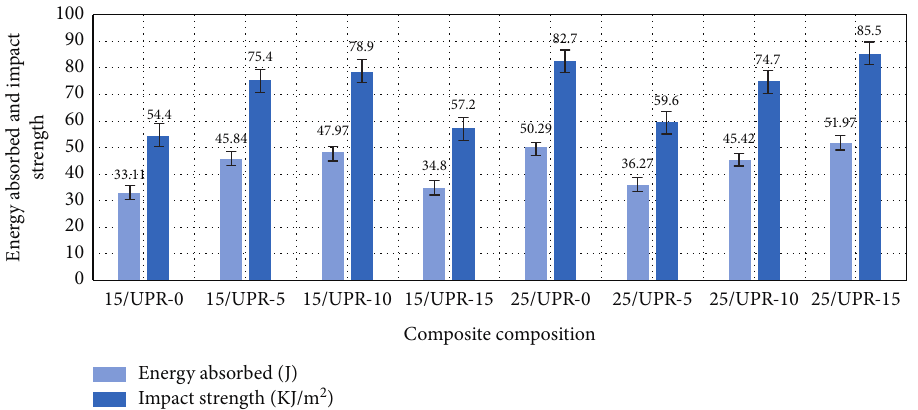
2 O 3 filler and chopped flax fiber.